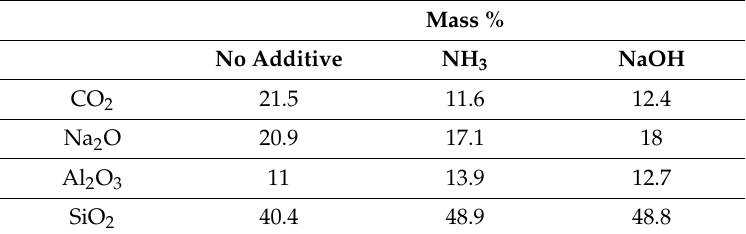
Table 2. XRF of geopolymers.